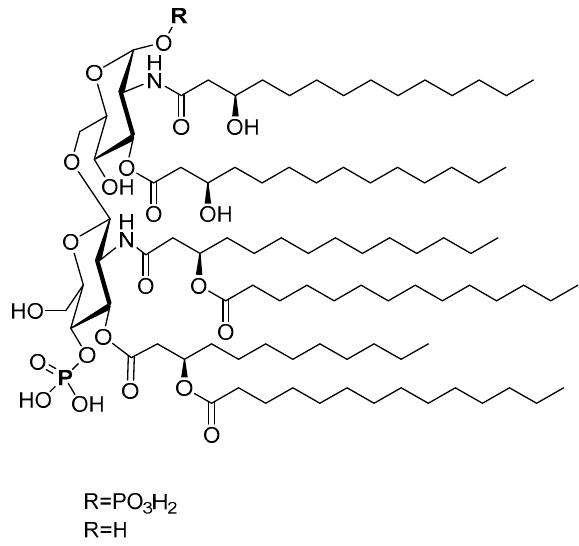
= PO 3 OH 2 ) and MPLA (R